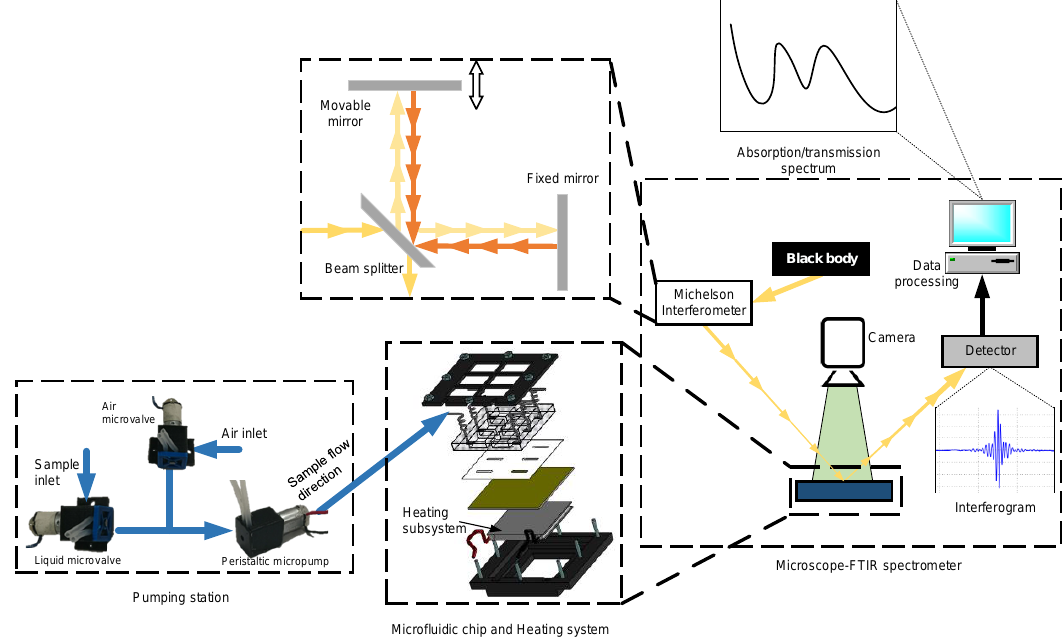
Figure 1. Schematic representation of the working principle of the proposed technique for sugar detection coupled to the developed microfluidic chip for sampling and sample handling and temperature